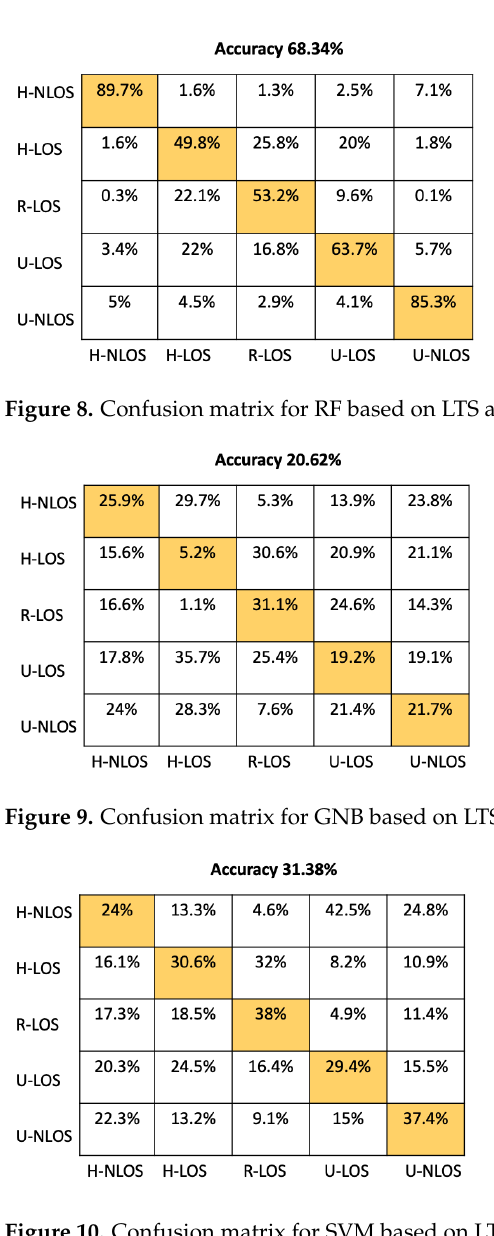
Figure 10. Confusion matrix for SVM based on LTS approach.